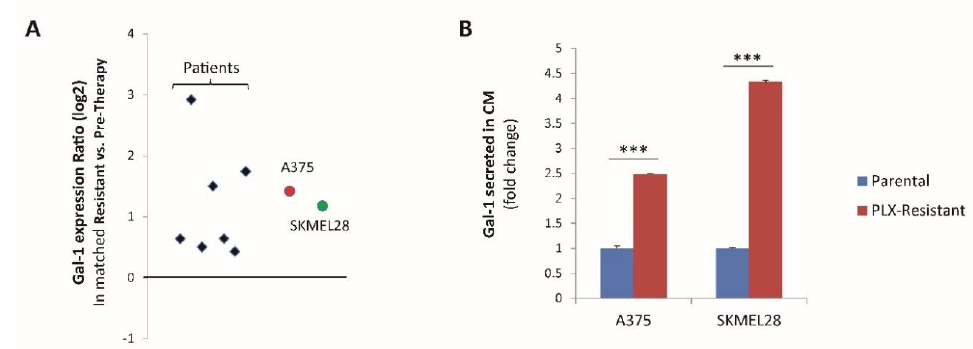
Figure 1. Galectin-1 upregulation in melanoma samples and cell lines resistant to BRAF-targeted therapy. ( A ) The graph shows Galectin-1 (LGALS1 gene) mRNA expression variation in paired melanoma samples (obtained from seven patients, indicated by black diamonds) before treatment with BRAF inhibitors and after the onset of secondary resistance (Log2 ratio resistant / pretherapy), as well as in A375 and SK-MEL-28 melanoma cells before and after developing resistance to 2 µ M PLX-4720 (Log2 ratio Resistant / Parental; n = 3). ( B ) Analysis of Galectin-1 protein levels (by PikoKine ELISA assay) in conditioned media (CM) derived from either parental or PLX4720-resistant A375 and SK-MEL-28 (PLX-resistant) cells. Data are normalized to levels detected in the respective parental cells and represent the average of a technical duplicate. Statistical significance was assessed by t -test, comparing parental and their derived PLX-resistant cell lines; *** p < 0.0001. Cancers 2020 , 12 , x